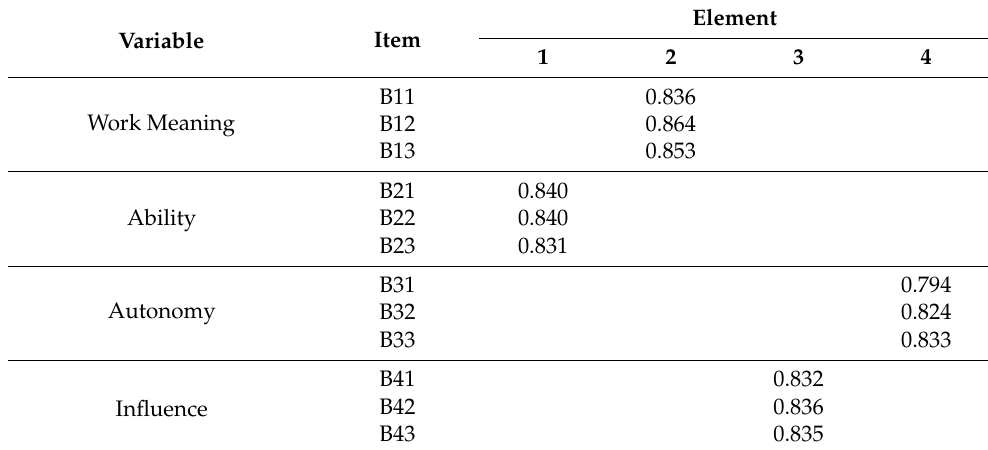
Table A4. Rotated Composition Matrix of Psychological Empowerment.